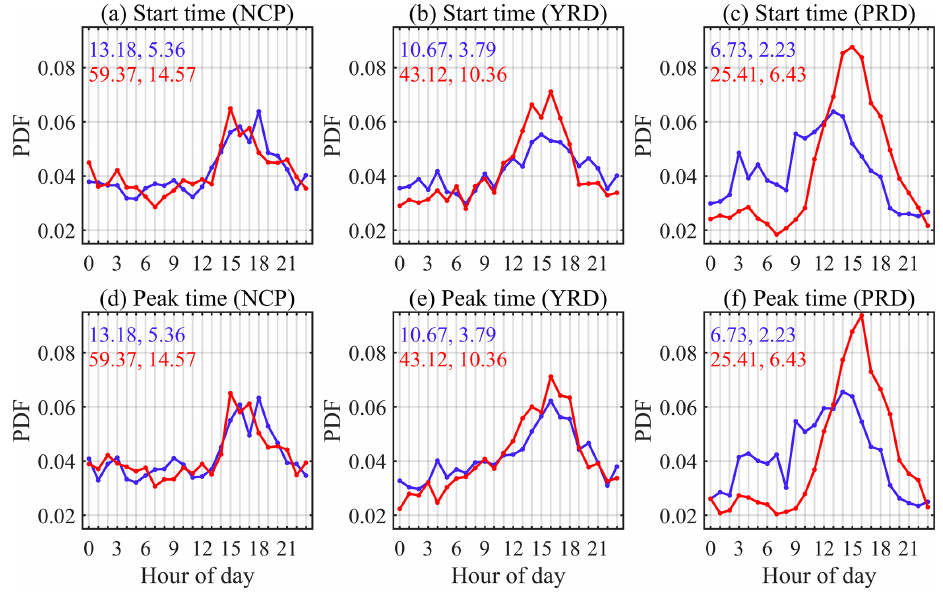
Figure 6. Normalised PDFs of precipitation (a–c) start time and (d–f) peak time (LT), represented as ratios of their corresponding precipi- tation frequency at a given hour to those accumulated over 24h under clean (blue lines) and polluted (red lines) conditions in June–August from 2015 to 2020 over the NCP, YRD, and PRD, respectively. The blue (red) numbers are the average (the first column) and standard deviation (the second column) of the PM 2 . 5 mass concentration (µgm − 3 ) under clean (polluted)